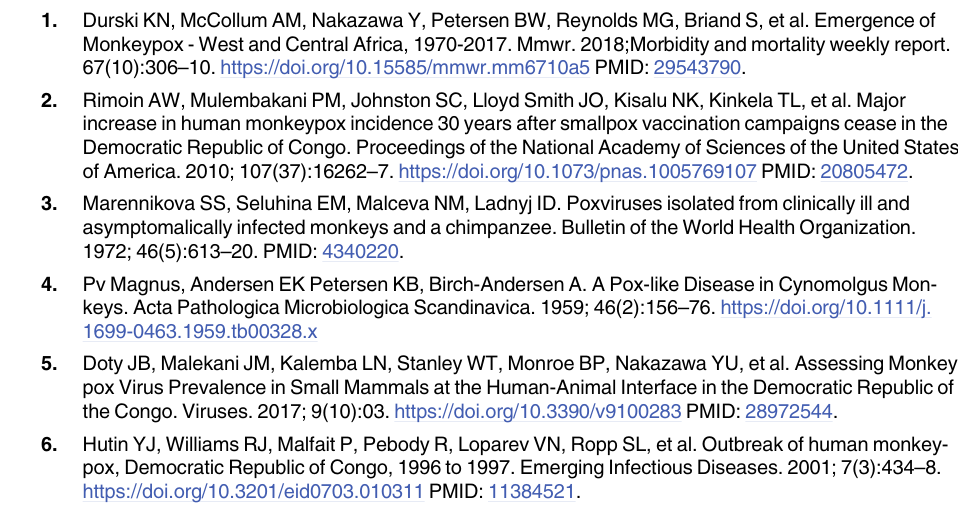
S4 Table. Case definition summary. S5 Table. Secondary attack rate table. S6 Table. Suspected, confirmed and fatal monkeypox cases by country and